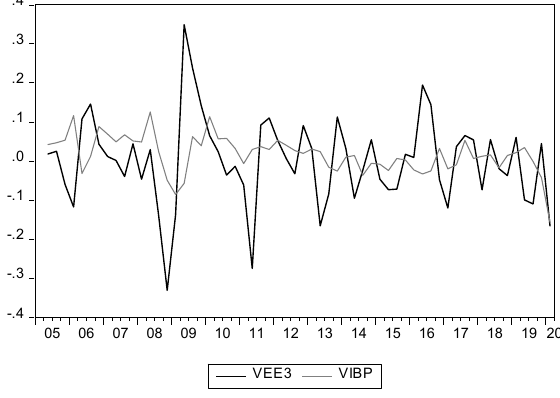
Fig. 3. Var% 3 month economic expectations - Var% private gross